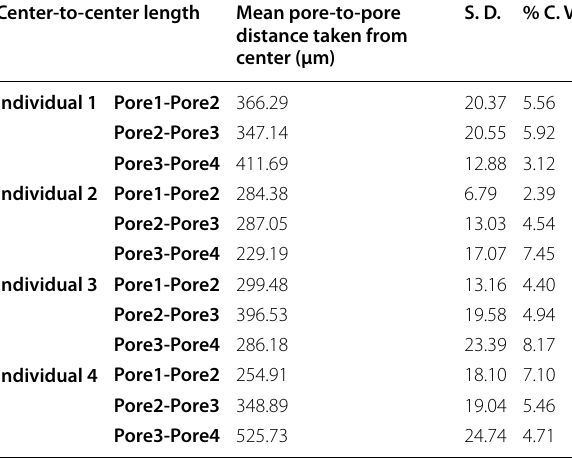
Table 5 Mean pore center-to-center distance, standard deviation (S. D.), and % coefficient of variation (% C.V.) of four pores, taken from fingerprints obtained from the left thumb of four individuals on glass, recorded on ten consecutive days, shows % C. V. to lie within and/or near acceptable levels (with 5% confidence level in analytical work), thereby demonstrating the reliability and reproducibility of pore inter-distance for matching